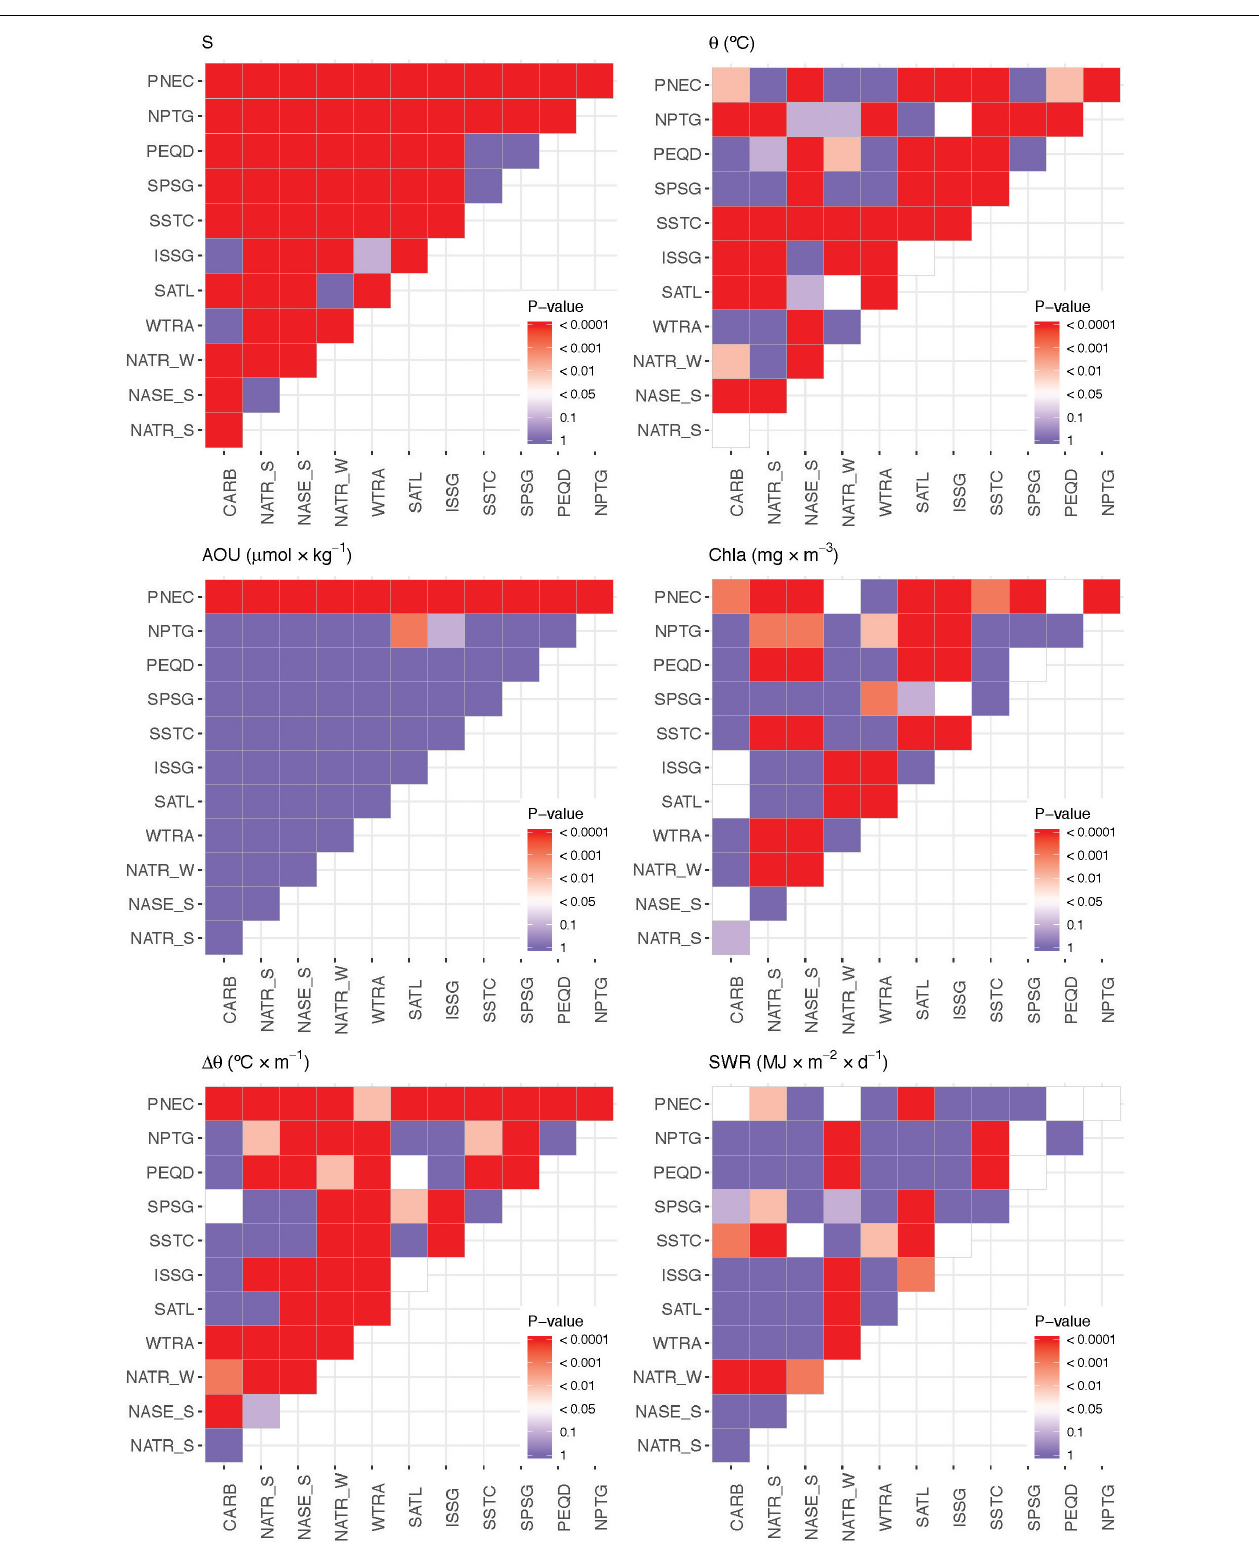
FIGURE 5 | P -value of the F-statistic test resulted from the ANOVA applied to the six environmental variables ( (cid:49) θ , SWR, S, θ , AOU and Chl a ), to evaluate inter-province variability.